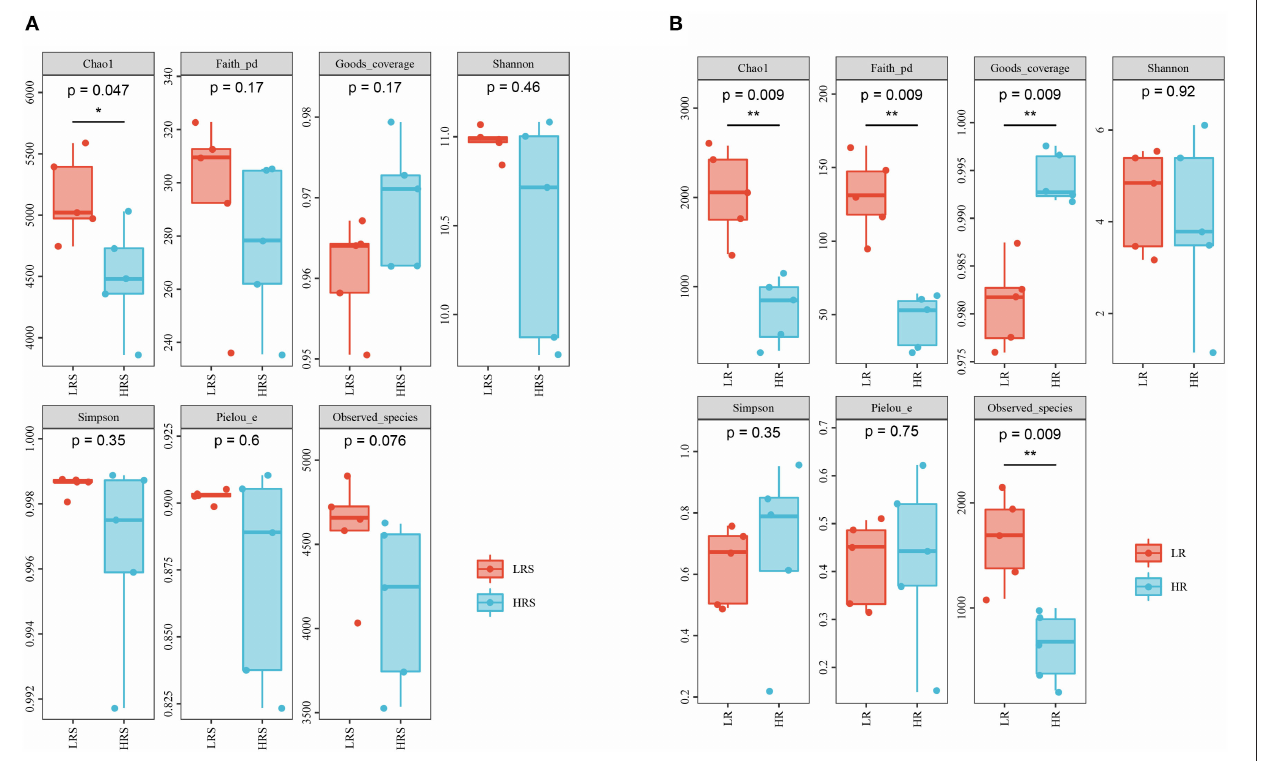
FIGURE 3 | The difference in the alpha-diversity indexes between the LR and HR soil (A) and cabbage roots (B) . * p < 0.05, ** p <